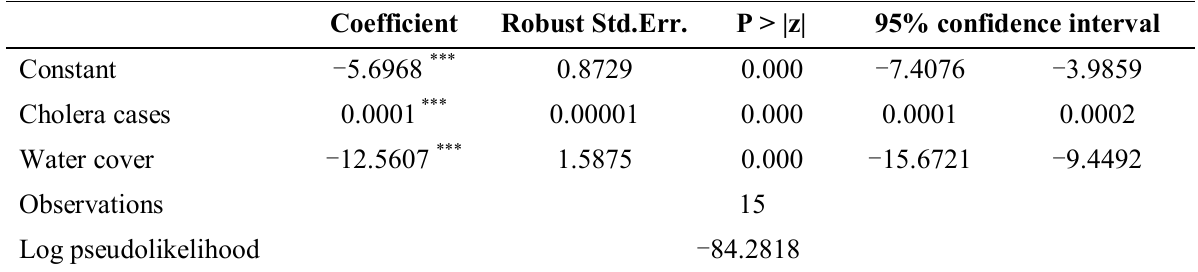
Table A4. Negative binomial model—Annual data: Cholera deaths and water